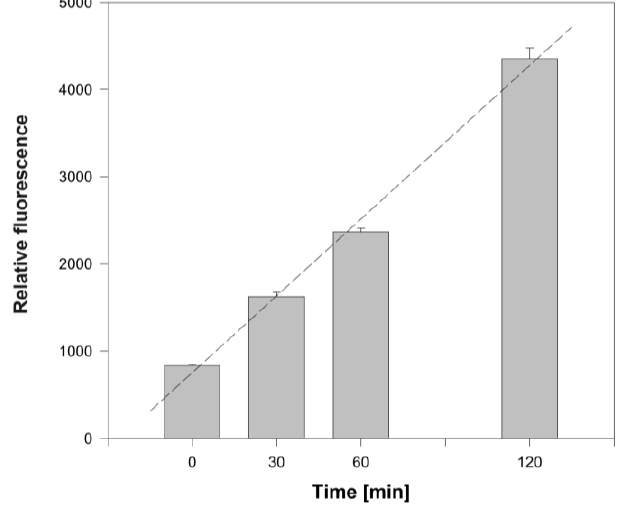
Figure 4. Time course of the PA adherence on an epithelial cell monolayer. Fluorescently labeled PA bacteria (1.5 × 10 7 CFU) were applied to wells and incubated at room temperature. At distinct time points bacteria were removed and the wells washed with